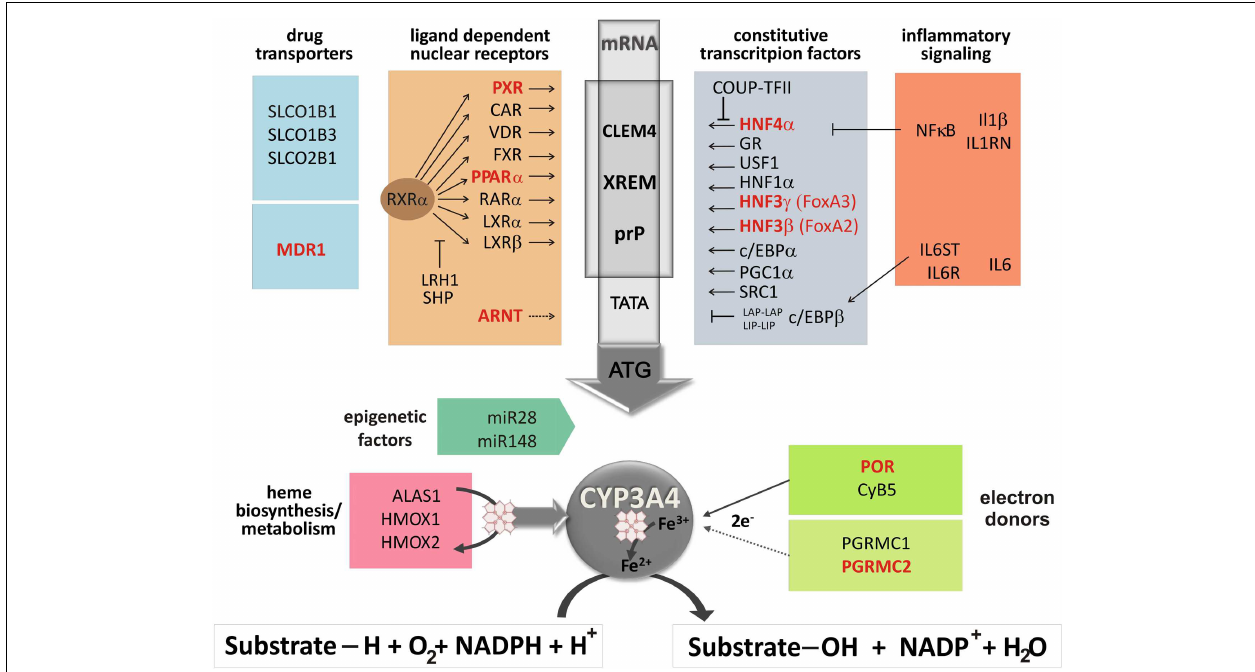
transcription factor II; CyB5, cytochrome B5; CYP3A4, cytochrome P450 3A4; FXR, farnesoid X-receptor; GR, glucocorticoid receptor;